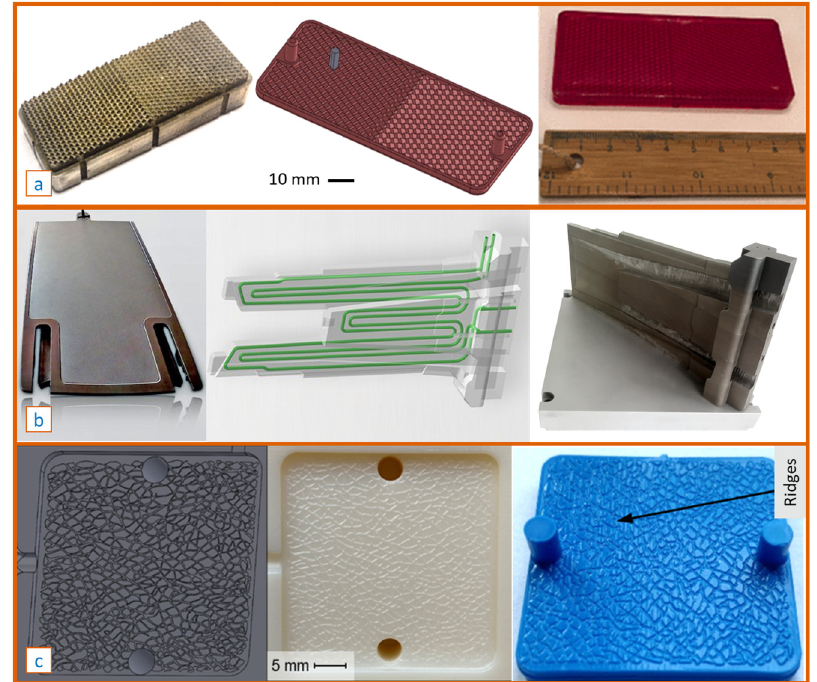
Figure 4. Polymer spare-part reconstruction based on indirect AM processes: ( a ) IM